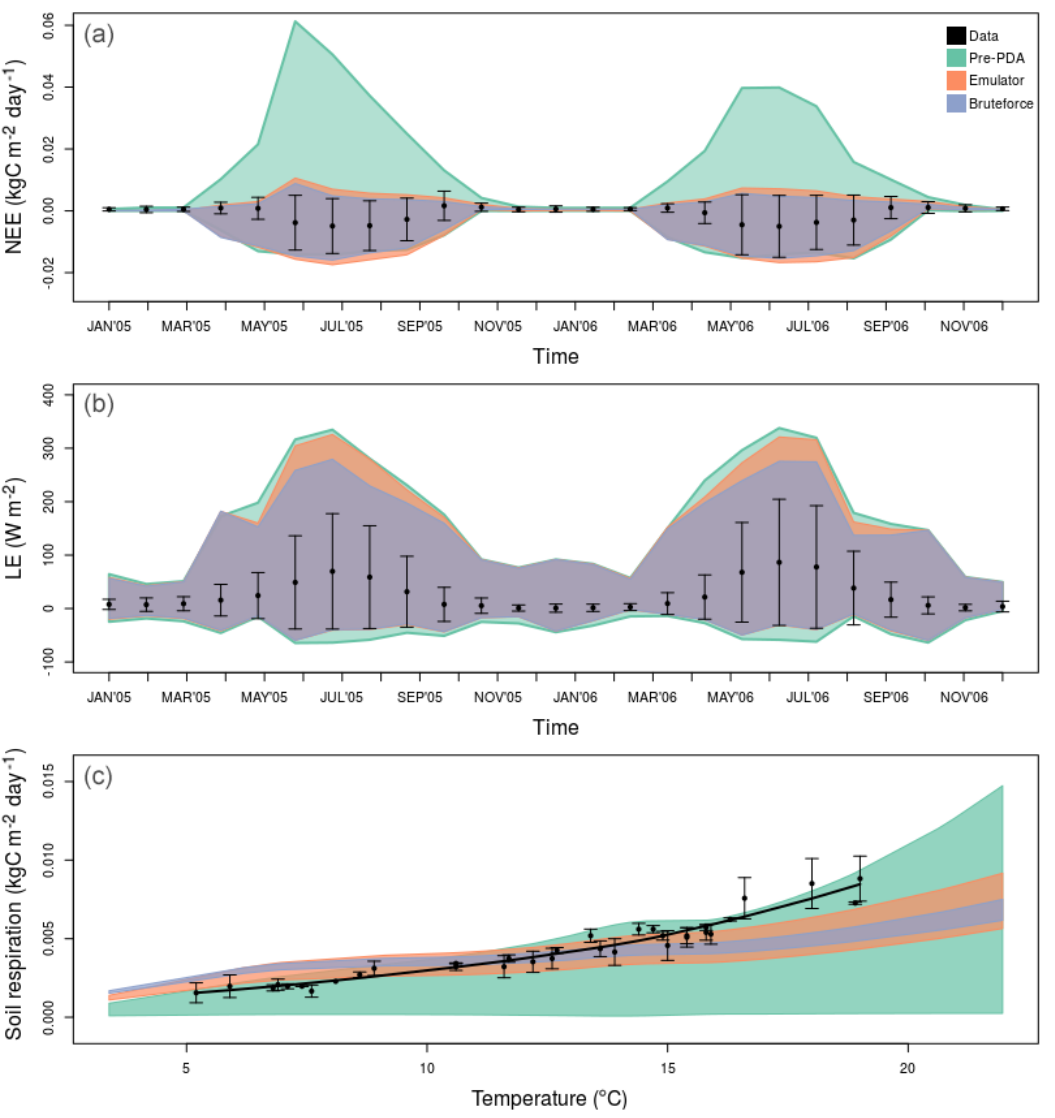
Figure 4. SIPNET performance against real data (black dots) after emulator (orange polygon) vs. brute-force (blue) calibration. The pre- PDA ensemble spread (green) was wider for all variables and was reduced with both methods. Panels (a) and (b) are monthly smoothed time series (for the unsmoothed version please see Fig. A1), while (c) shows the temperature–soil respiration response curve, plotted with a locally weighted scatter plot smoothing (LOESS) line and residuals from a fitted temperature response function as a conservative estimate of the error bars. All polygons show the 2.5%–97.5%